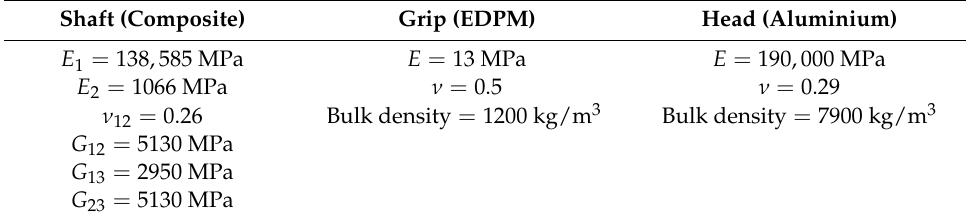
Figure 1. Studied club (length 101.6 cm). Table 1. Mechanical characteristics of the golf shaft before updating, [34]. The parameters are as follows: E for Young’s modulus, ν for Poisson’s ratio, and G for shear modulus.